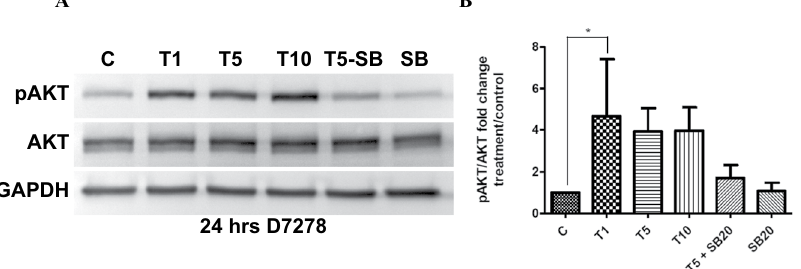
Figure 2. TGF- β induces phosphorylation of AKT in human TM cells. ( A ) Western blot analysis of AKT and its phosphorylation (pAKT- ser473) in TM cells treated with TGF- β 2 (1, 5 or 10 ng/ml). Protein was extracted at 24 h. TGF- β receptor signaling was inhibited using SB431542 (SB; 20 μ M). D7278- representative human donor. ( B ) Densitometry was performed on AKT and pAKT Western blot data using ImageJ software. Statistical significance was determined using one-way ANOVA with Tukey’s post-hoc. * p < 0.05. N =